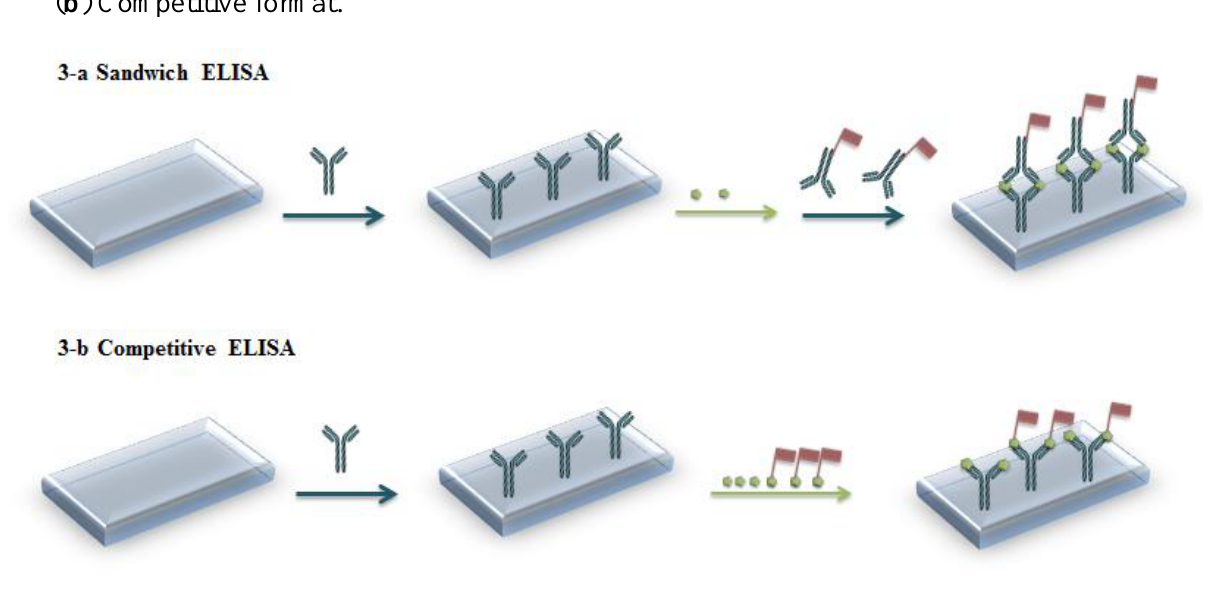
Figure 1. Principle of enzyme-linked immunosorbent assay (ELISA). ( a ) Sandwich format ( b ) Competitive